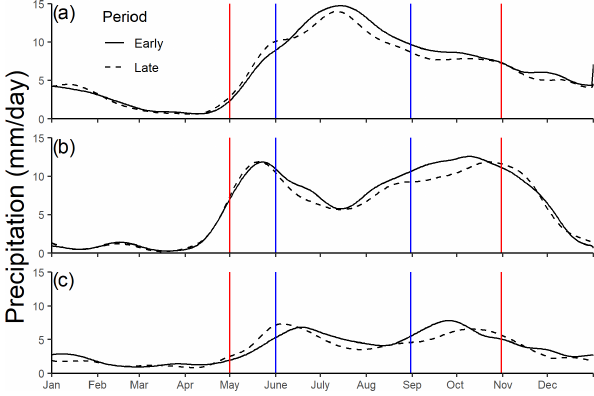
Figure 6. Twenty-year average precipitation (mmd − 1 ) pattern at (a) point 1 with MSD in 1981–2000 but not 2001–2020, (b) point 2 with MSD in 1981–2000 but not 2001–2020, and (c) point 3 with MSD in 2001–2020 but not 1981–2000. As with Fig. 5, key time windows are indicated by vertical